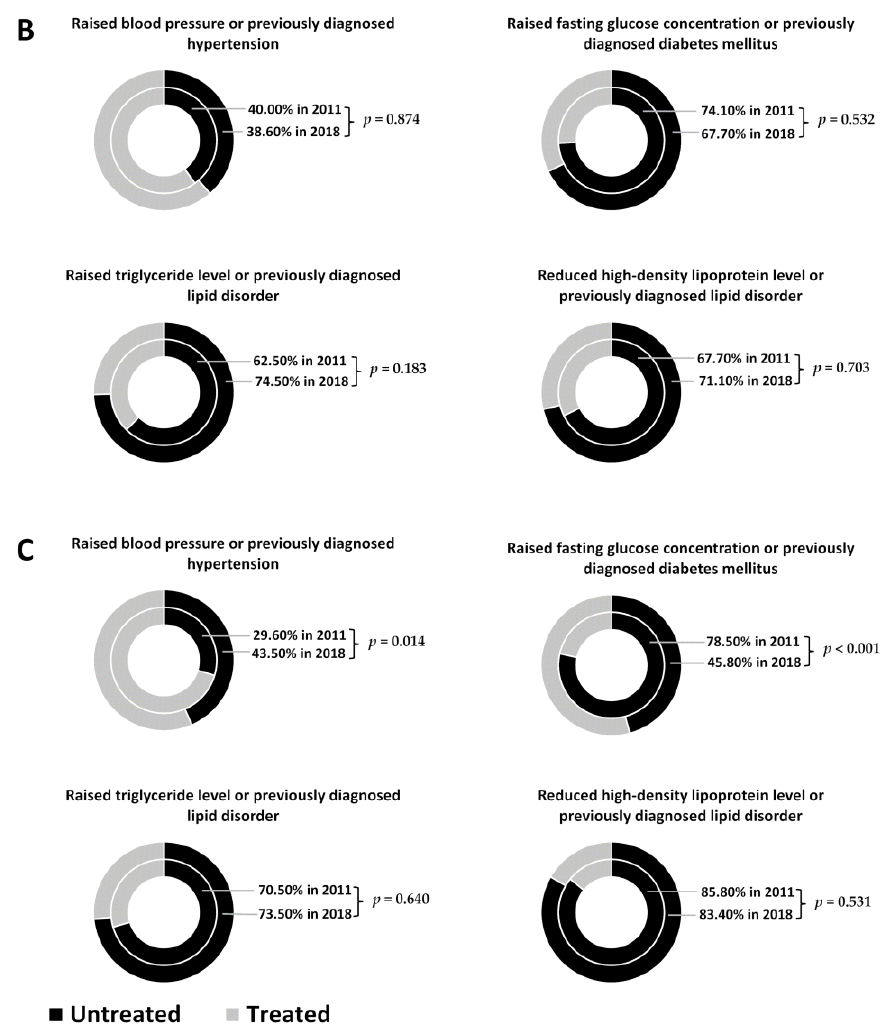
Figure 3. Changes in the prevalence of individuals untreated for the four treatable components of metabolic syndrome (MetS) by study population ( A ) and by sex (male— B ; female— C ) from 2011 to